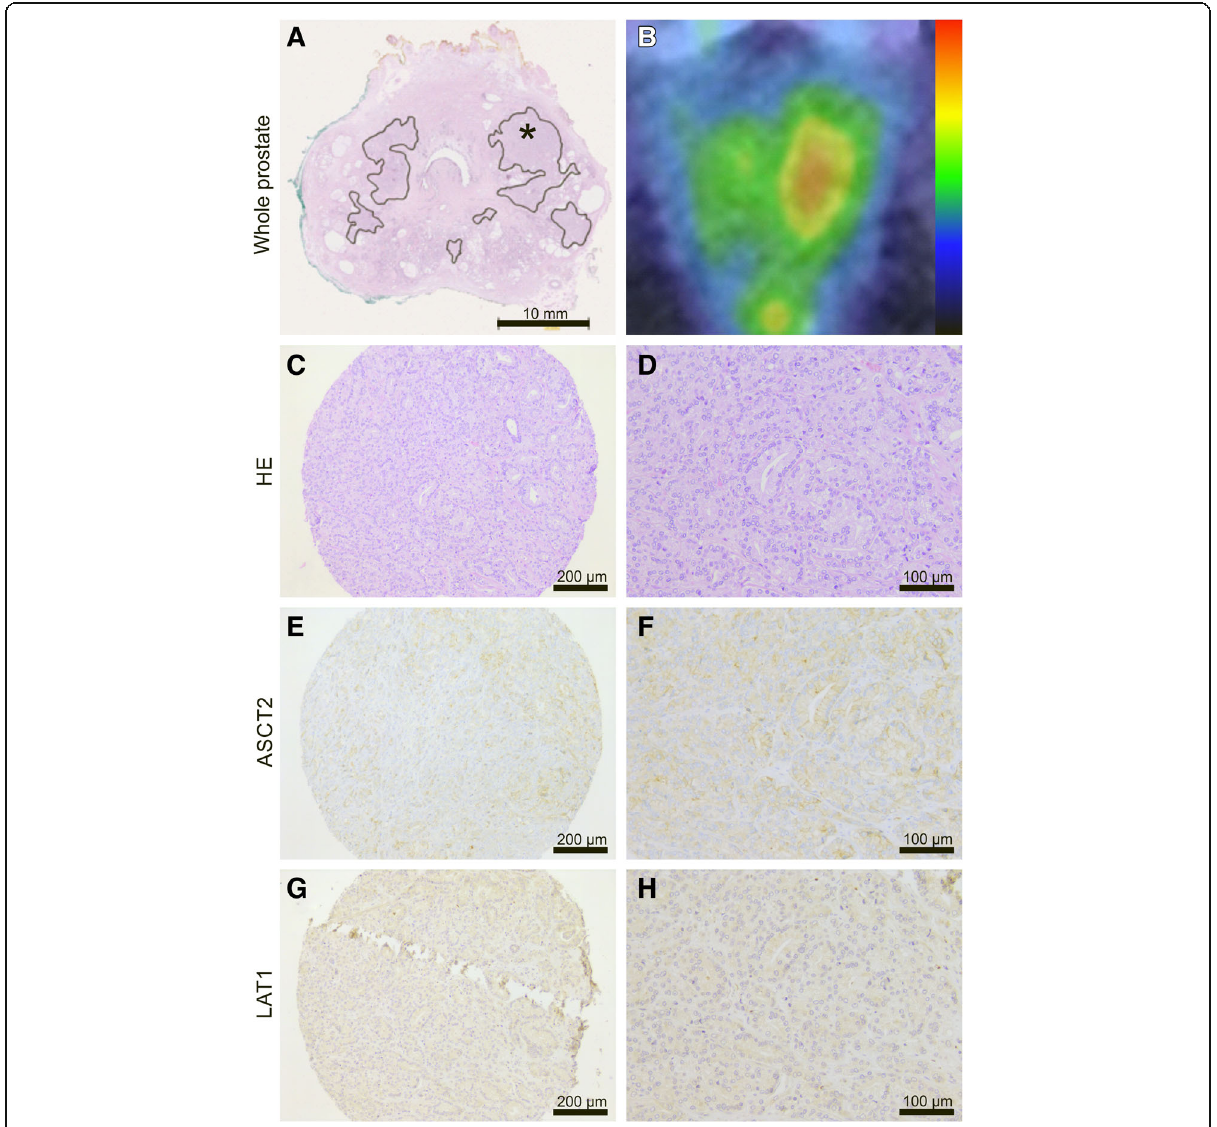
Fig. 6 A representative case of a 67-year-old patient with preoperative PSA of 6.2 ng/ml. HE staining of whole-mount prostatectomy section indicates a bilobar adenocarcinoma with index lesion in the left lobe (marked with *) and another tumor in the right lobe ( a ). Axial PET/CT shows moderate 18 F-fluciclovine uptake in the index lesion (SUV max at 22min=3.2) and low uptake in the right lobe tumor ( b ). Low (×10) and high (×20) magnification images of HE-stained TMA core from the left index tumor shows Gleason 4+5 adenocarcinoma ( c , d ). Parallel sections show low ASCT2 ( e , f ) and LAT1 ( g , h ) staining